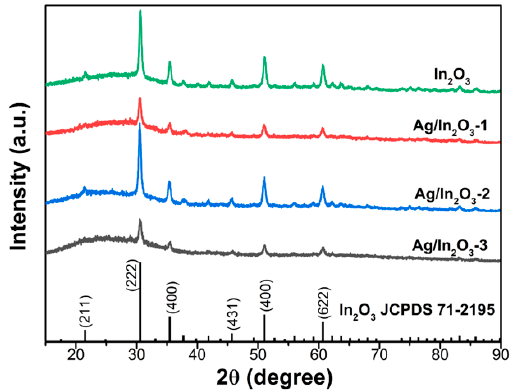
Figure 1. XRD patterns of the prepared bare In 2 O 3 and Ag-decorated In 2 O 3